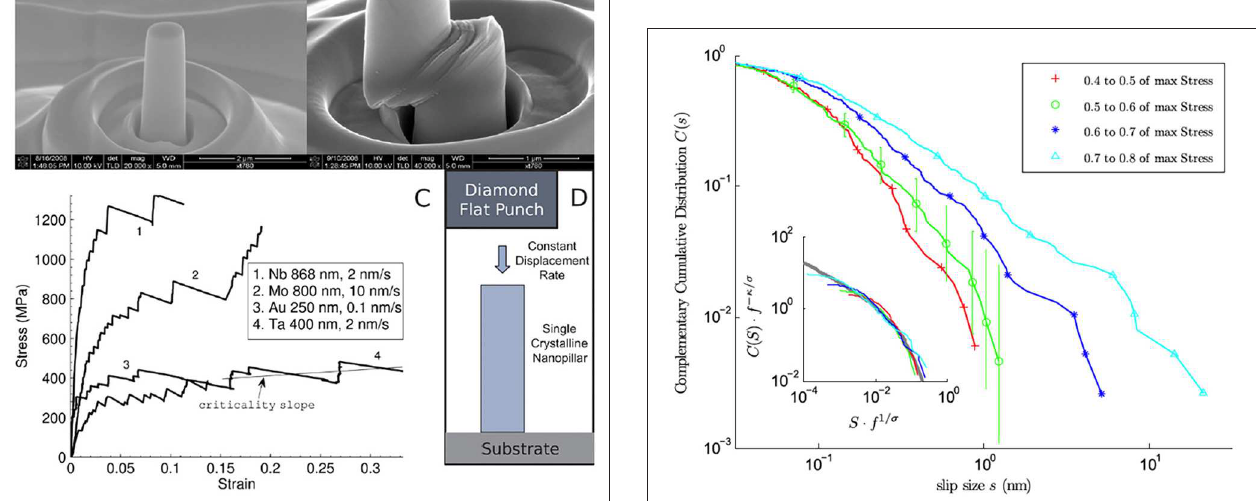
FIGURE 1 | Nanopillar compression tests from Friedman et al. [4]. (A,B) Scanning electron micrographs of a 868-nm-diameter Nb pillar at 52 ◦ tilt, before, and after compression, respectively. (C) Stress-strain curves for increasing stress (each contains thousands of points) for four metals compressed at different displacement rates. Negatively sloped lines connect two points at the beginning and end of fast slips. The Nb stress-strain curve corresponds to the pillar in (A,B) . (D) Schematic of the compression test methodology. For details, see [4] and references therein [Reprinted with permission from Friedman et al. [4] Copyright (2012) by the American Physical Society].